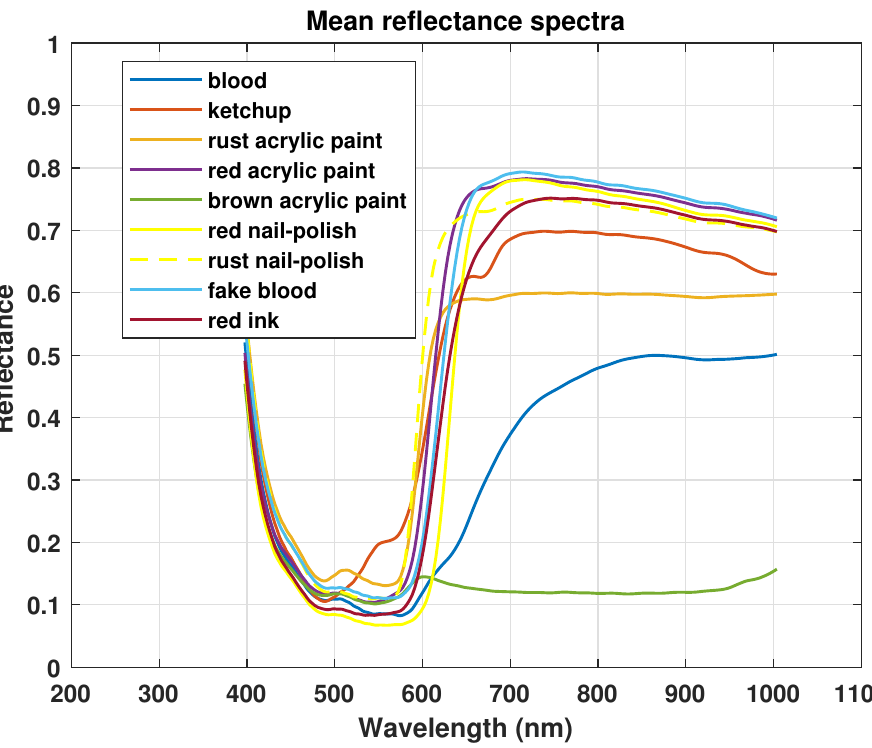
Figure 7. Comparison of spectra of aged blood and different non-blood samples on wall